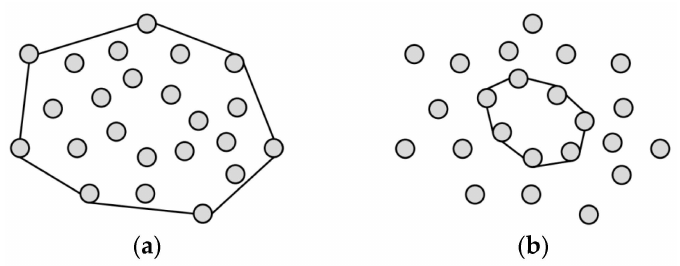
Figure 1. ( a ) Minimum convex hull; and ( b ) Inner convex hull.